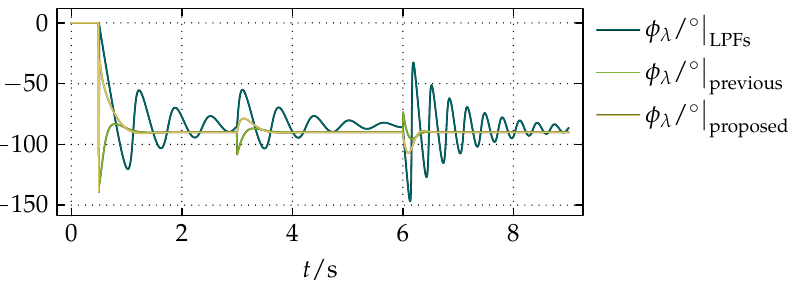
Figure 12. The results of φ λ obtained by a comparative simulation of the standard solution with LPFs presented in [5–11], the previous compensation presented in [23], and the proposed compensation.